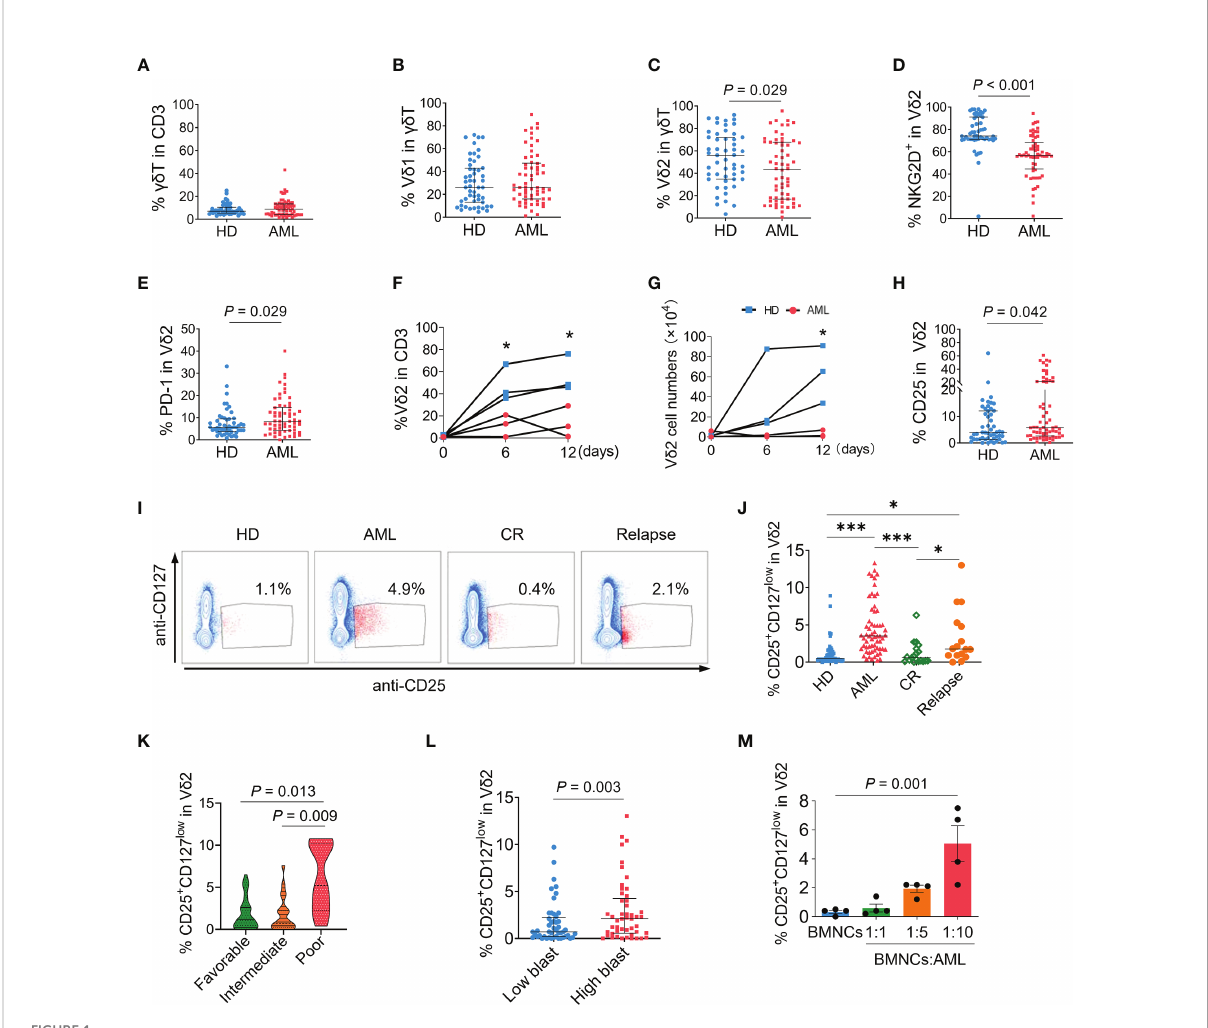
FIGURE 1 Immunophenotypes of gd T cells and association of CD25 + CD127 low V d 2 + T cells with AML. Flow cytometry analyses for gd T cells in the bone marrow samples from newly-diagnosed AML patients (n = 62), compared with healthy donors (HD, n = 51). (A) The proportions of total gd T cells in CD3 + T cells. (B, C) The proportions of V d 1 and V d 2 subsets in gd T cells. Expressions of NKG2D (D) , and PD-1 (E) on V d 2 T cells. Bone marrow mononuclear cells (BMNCs) isolated from healthy donors and AML patients were stimulated with IPP for indicated time course. The proportions of V d 2 cells in CD3 + T cells (F) were detected by fl ow cytometry and the absolute numbers of V d 2 cells were counted (G) . Expressions of CD25 (H) on V d 2 T cells. Representative dot-plot images by fl ow cytometry (I) and the statistical analyses (J) of the frequency of CD25 + CD127 low V d 2 + T cells in bone marrow samples from healthy donors, and AML patients at diagnosis, complete remission (CR) after chemotherapy (n = 19), and relapse (n = 16). * P < 0.05, ** P < 0.01, *** P < 0.001. (K) The frequencies of CD25 + CD127 low V d 2 + T cells in bone marrows of newly-diagnosed AML patients with favorable (n = 34), intermediate (n = 19), and poor (n = 9) risk status. (L) Comparison of the frequency of CD25 + CD127 low V d 2 + T cells in patients with ≤ median (low) and > median (high) load of AML blast. (M) The proportions of CD25 + CD127 low V d 2 + T cells in V d 2 T cells after co-culture of primary AML cells isolated from patients with BMNCs from healthy donors at indicated ratios for 48 hours. n = 4. Statistical differences in (A – H) and (L) were analyzed using the non-parametric (Mann-Whitney) t test, (I) and (K) using the Kruskal-Wallis H-test, and (M) using the one-way analysis of variance (ANOVA). P values are indicated on the